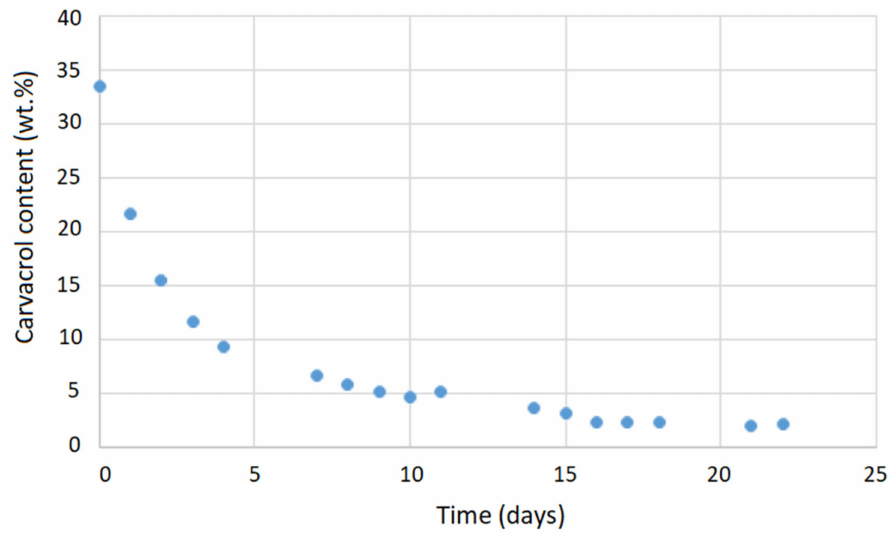
Figure A10. Carvacrol release in air at 25 ◦